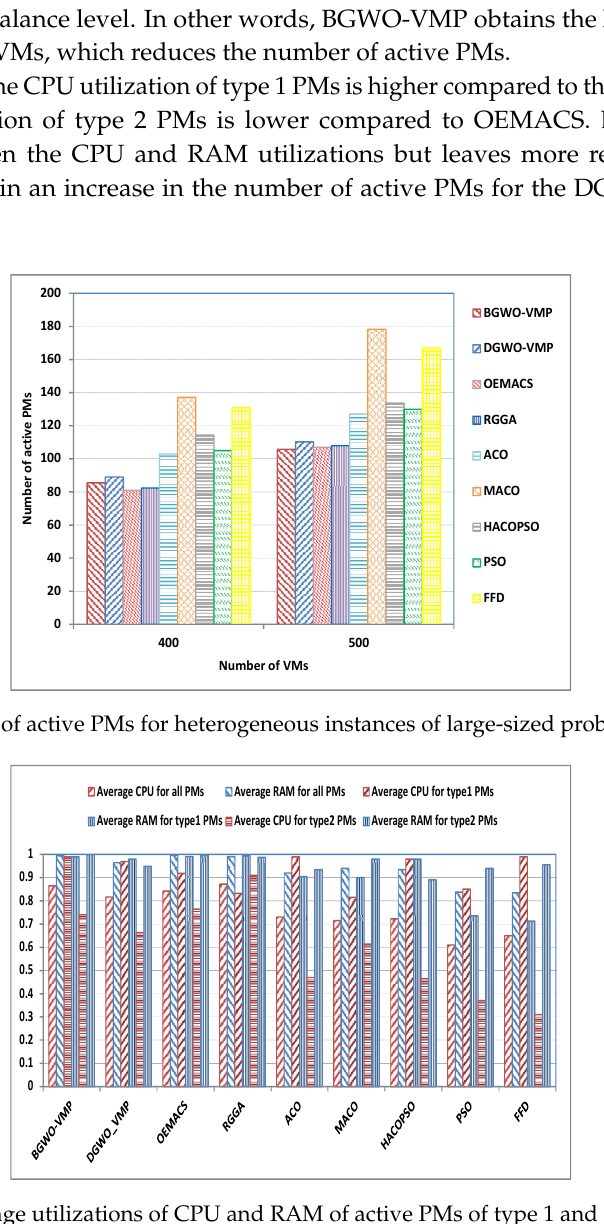
Figure 6. Average utilizations of CPU and RAM of active PMs of type 1 and type 2 on